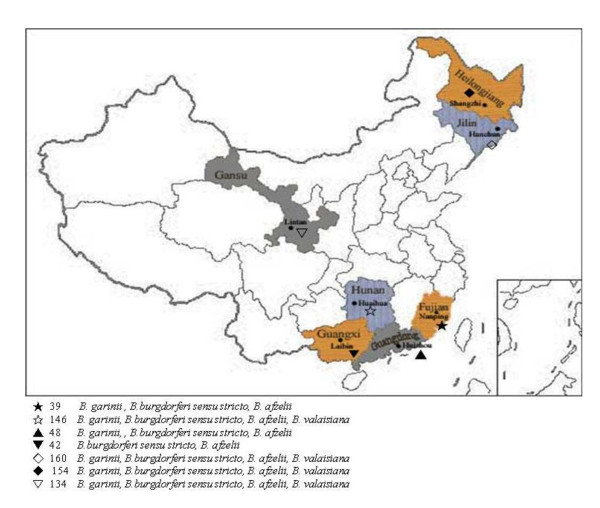
Map of China showing the number of ticks examined in each of the seven regions in this study.